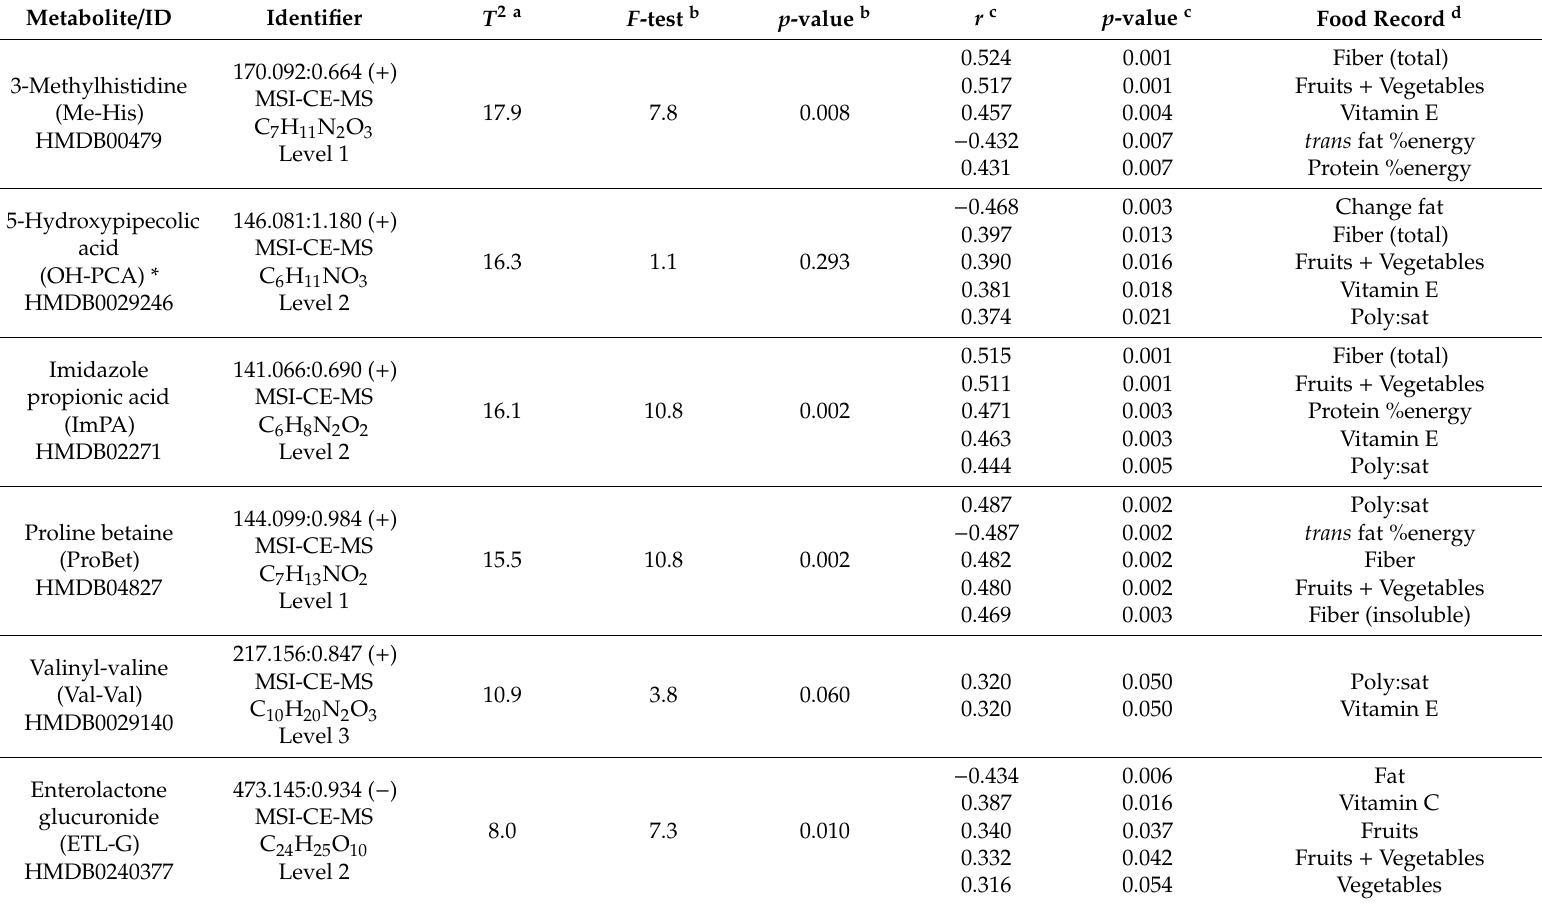
Table 3. Top-ranked creatinine-normalized metabolites associated with contrasting diets by DIGEST participants ( n = 42) when using time series MEBA, mixed ANOVA, and partial correlation